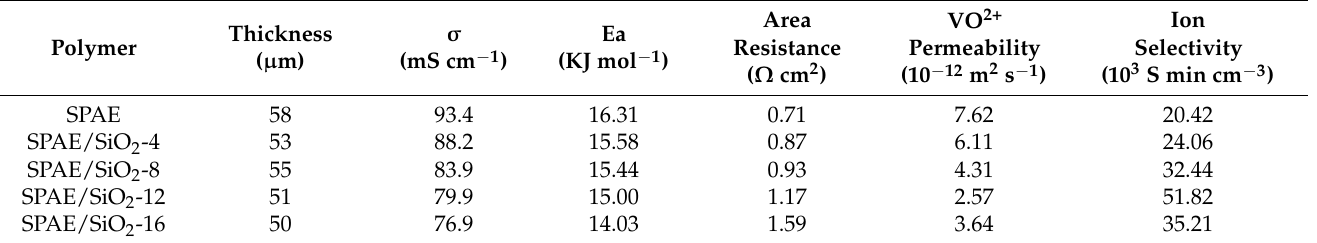
Table 2. Properties of the SPAE and SPAE/SiO 2 composite PEMs at room temperature.